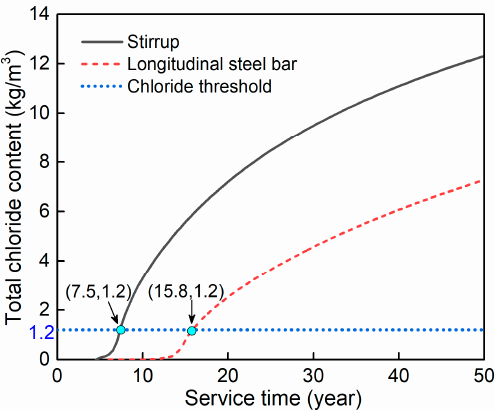
Figure 1. Simulation result of total chloride content distribution after servicing for 50 years.